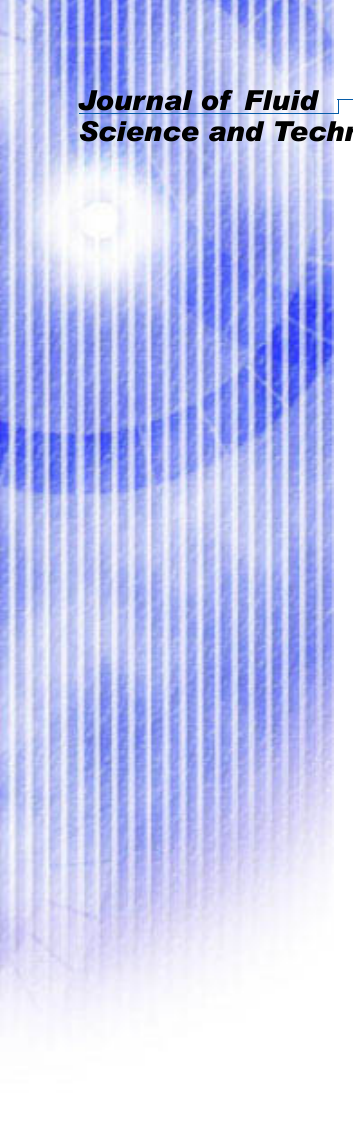
Fig.13 Comparison of experiment with calculation